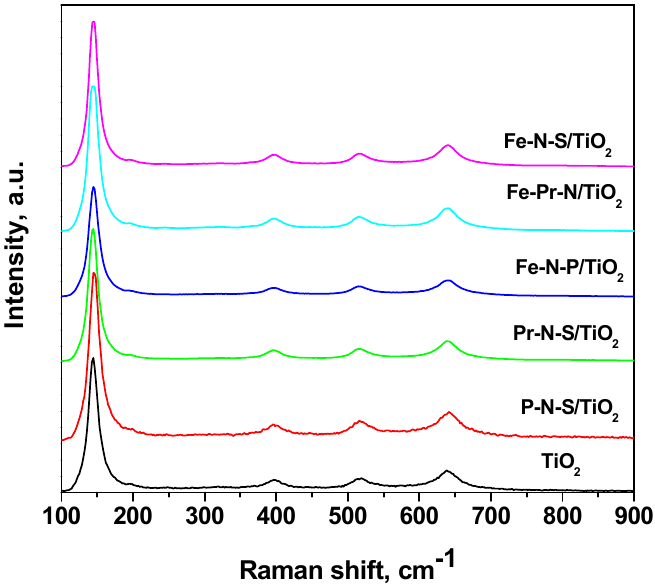
Figure 3. Raman spectra of all the prepared samples.